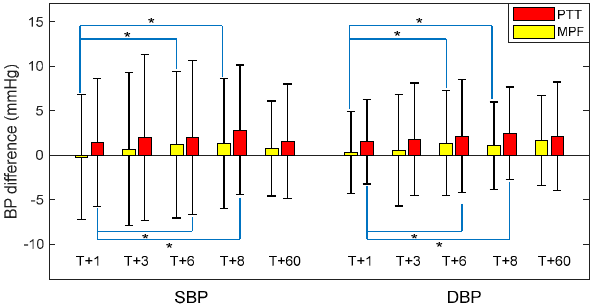
Figure 10. Estimation error for SBP and DBP at different time intervals (* indicates statistical significance at 0.05).